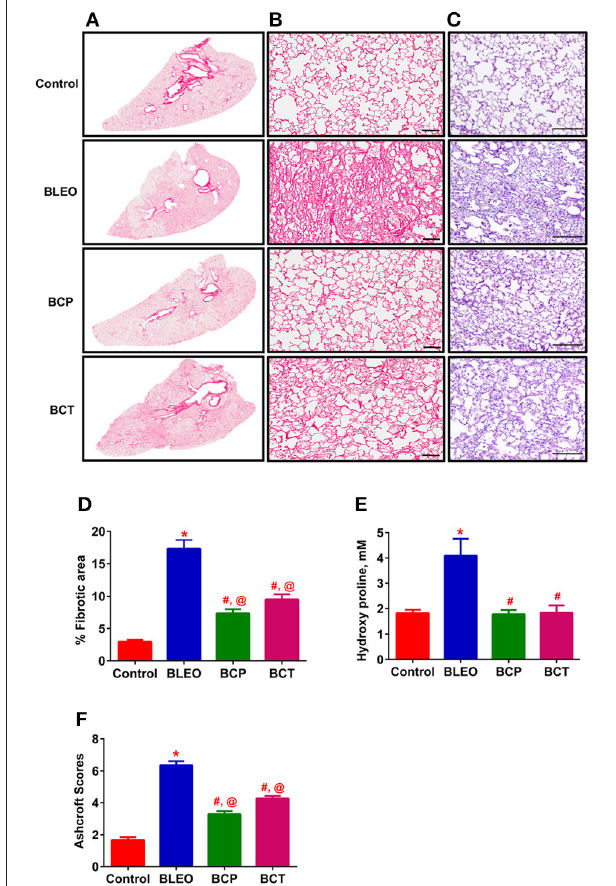
FIGURE 2 | C21 treatment attenuates lung fibrosis and tissue remodeling in BLEO animals. (A) Picro-sirius stained images of the whole lung; Con,